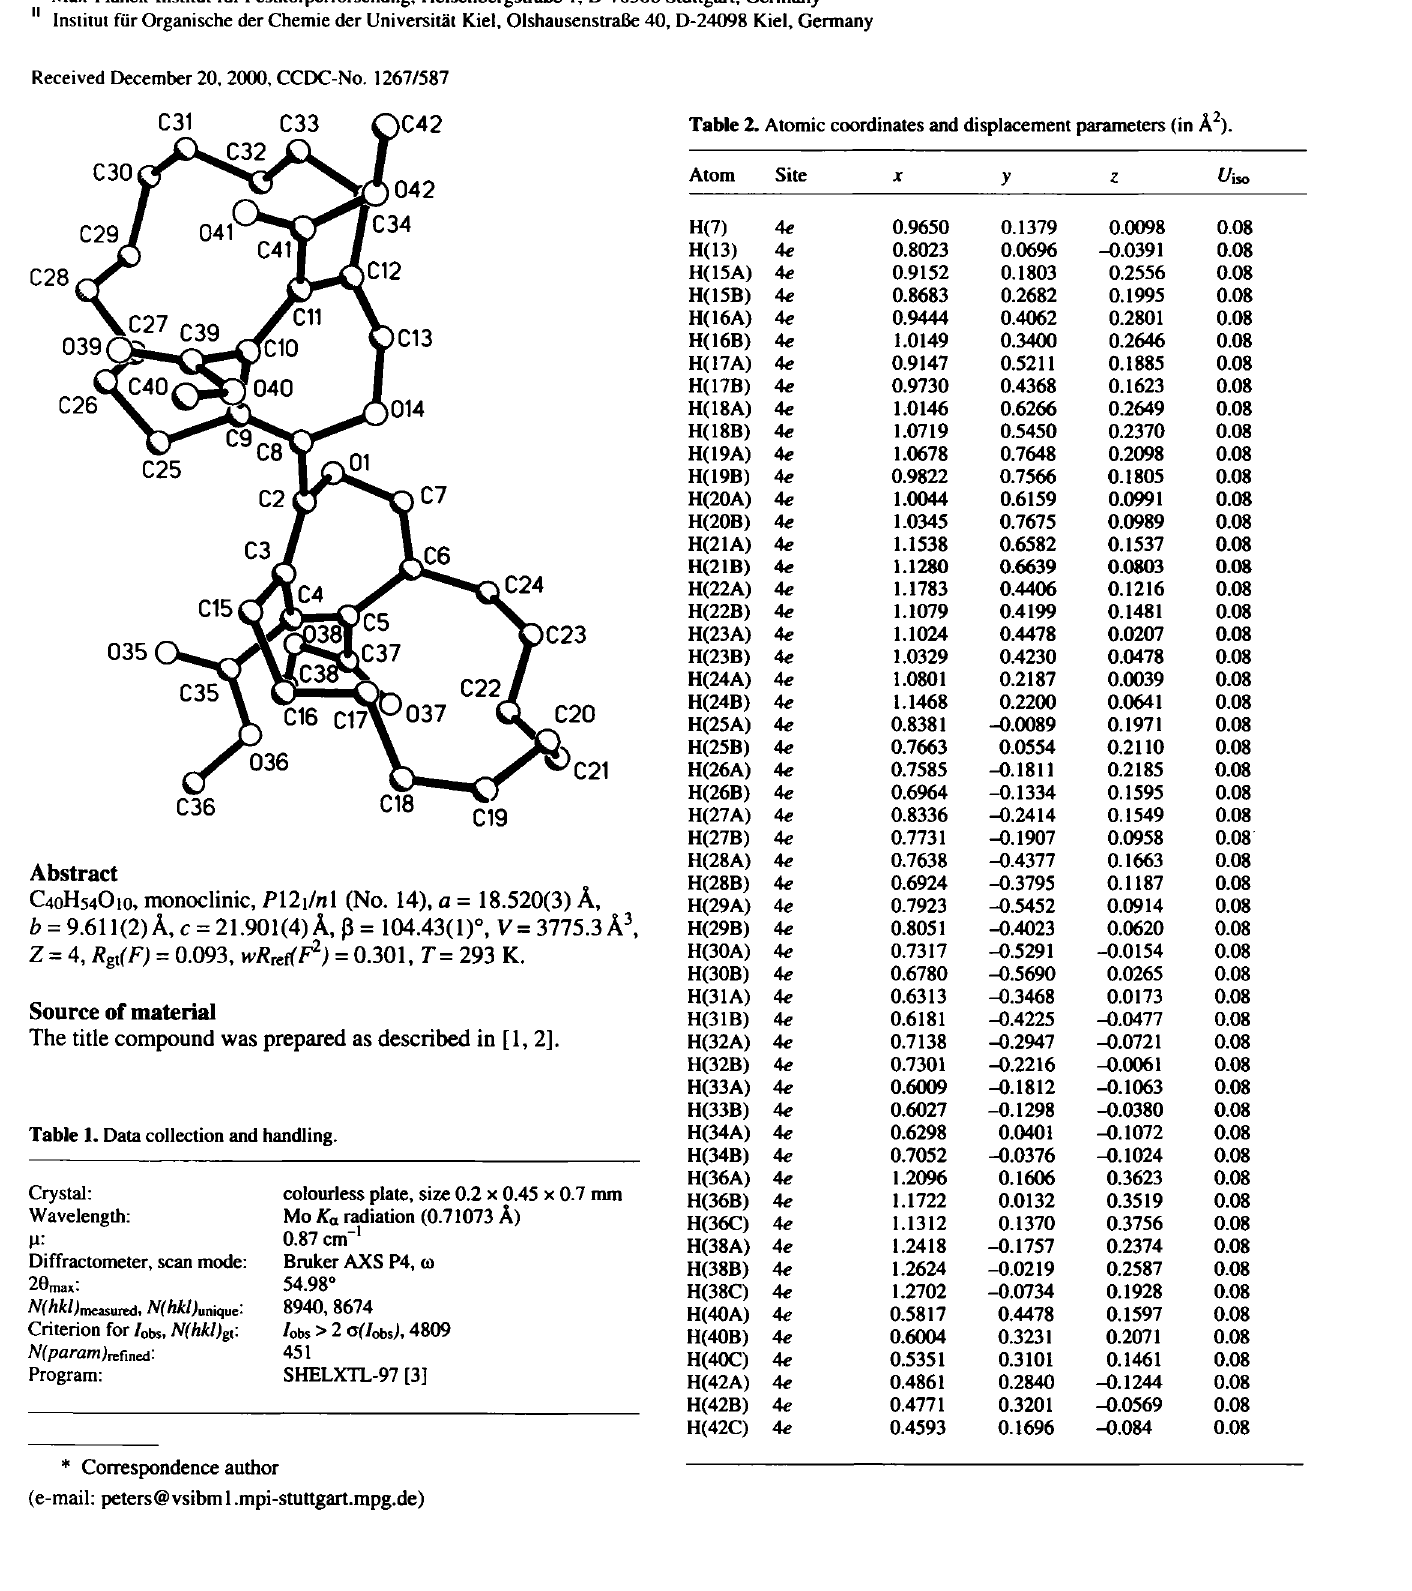
Table 2. Atomic coordinates and displacement parameters (in A 2 ).